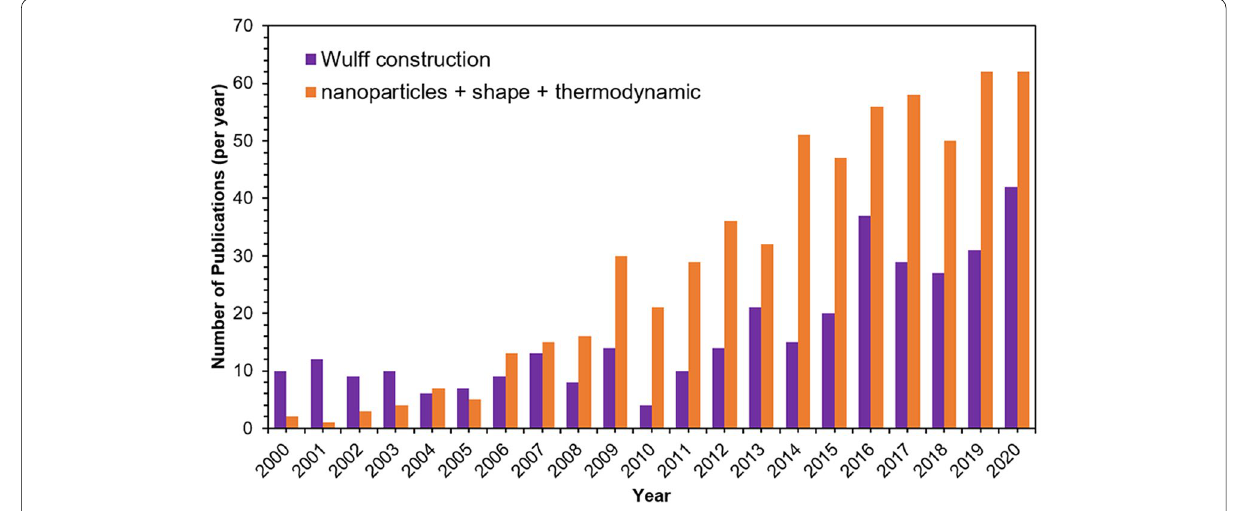
Fig. 1 Yearly number of publications featuring the words “Wulff construction” (purple) or all of the words “nanoparticle”, “shape” and “thermodynamic” (orange) in their title or abstract. Data obtained from https:// app. dimen sions. ai/ disco ver/ publi